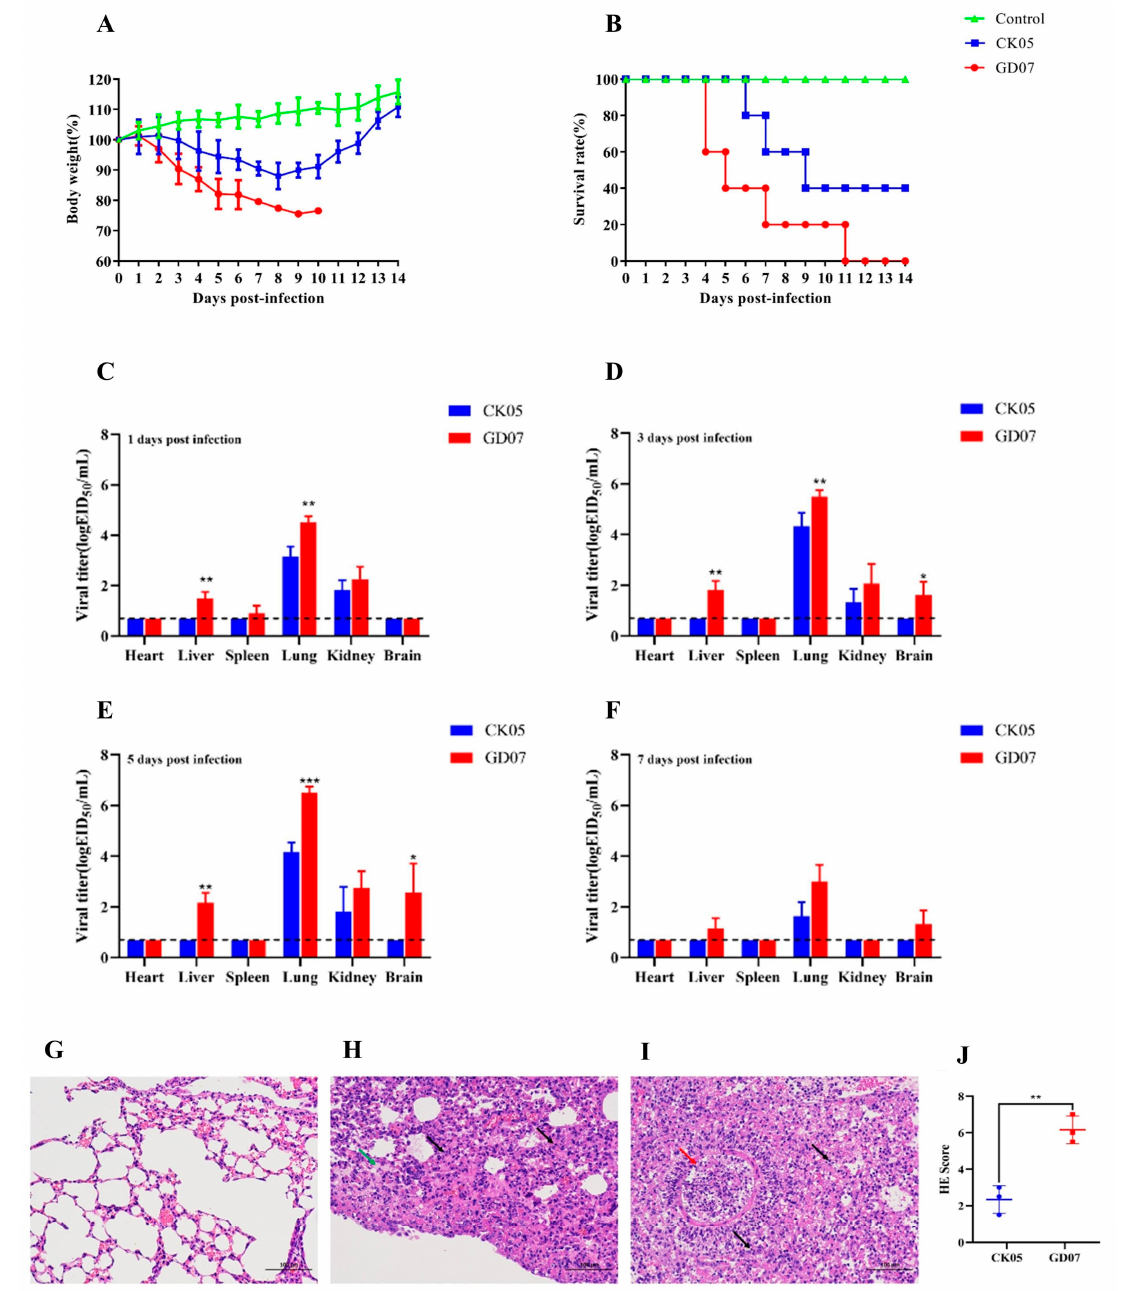
Figure 4. Pathogenicity of the isolated viruses in mice. All mice were intranasally inoculated with the H5N6 viruses at 10 6 EID 50 . ( A ) The daily weight of each group was monitored for 14 days. ( B ) The survival rate of each group was recorded for 14 days. ( C ) The tissue distribution of the CK05 and GD07 virus in BALB/c mice at 1 dpi. ( D ) The tissue distribution of the CK05 and GD07 virus in BALB/c mice at 3 dpi. ( E ) The tissue distribution of the CK05 and GD07 virus in BALB/c mice at 5 dpi. ( F ) The tissue distribution of the CK05 and GD07 virus in BALB/c mice at 7 dpi. ( G ) Lung pathological sections of the BALB/c mice in the control group at 5 dpi. ( H ) Lung pathological sections of the BALB/c mice in the CK05 group at 5 dpi. ( I ) Lung pathological sections of the BALB/c mice in the GD07 group at 5 dpi. ( J ) Pathological scores in the lungs of infected BALB/c mice. Images were acquired using a ×20 magnification objective. Alveolar wall thickening, lymphocyte infiltration (arrow black); acidophilic protein-like exudation (arrow green); epithelial cell necrosis (arrow red). * p < 0.05, ** p < 0.01, *** p < 0.001. LLOD for viral titers is indicated with a black dotted line.